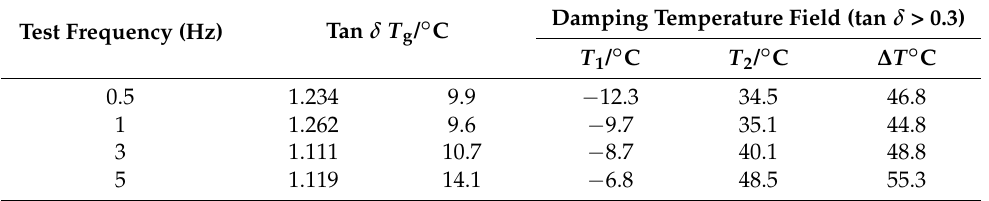
Table 8. Summary of DMA data of PUs with different test frequencies.